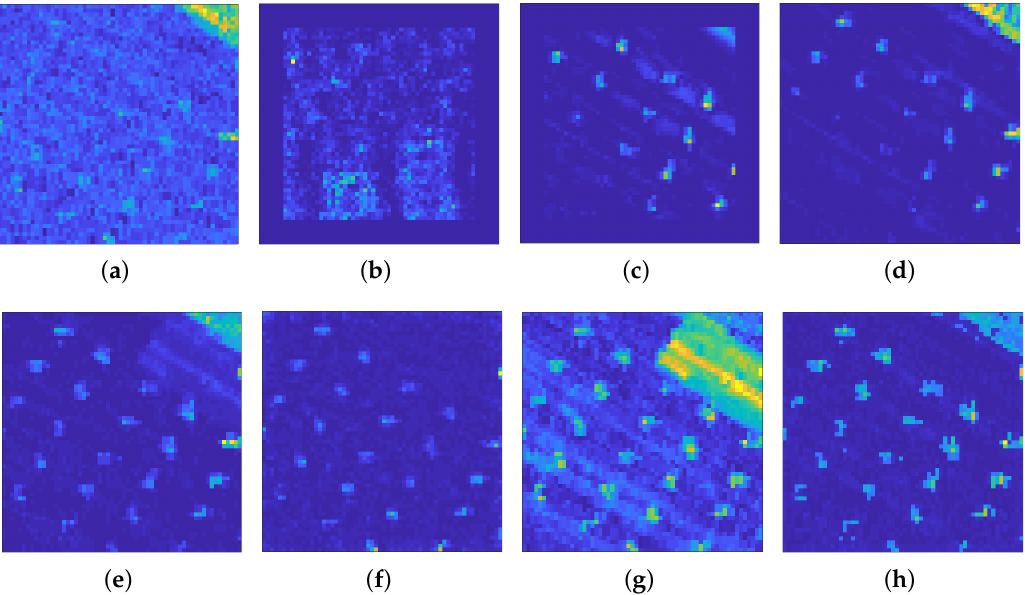
Figure 10. Two-dimensional maps of detection results by different algorithms for the AVIRIS–II dataset.